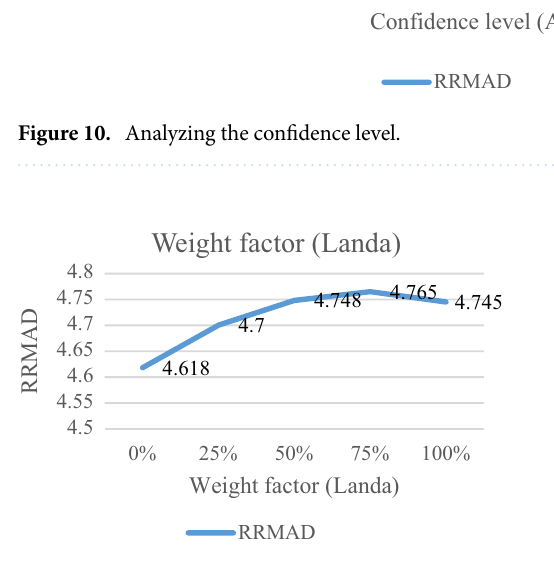
Figure 11. RRMAD for weight factor.